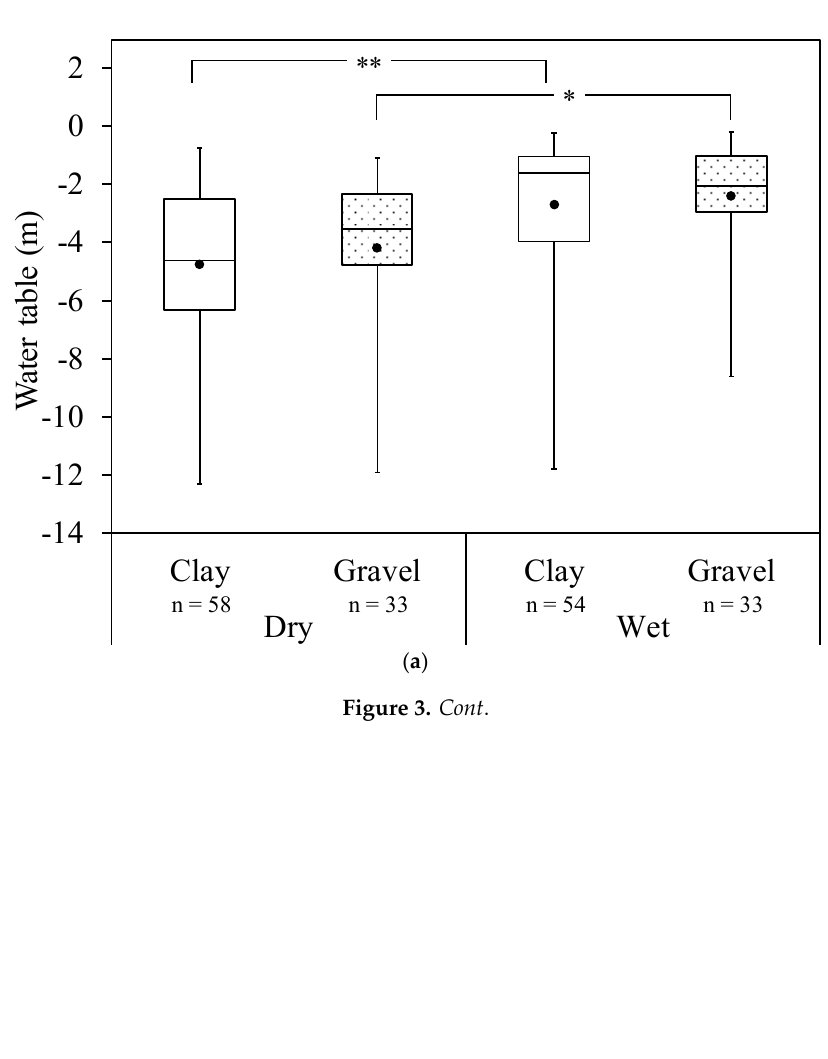
Figure 3c. The gravel aquifers have a higher average NH 4 -N concentration (1.8 mg-N / L) than clay